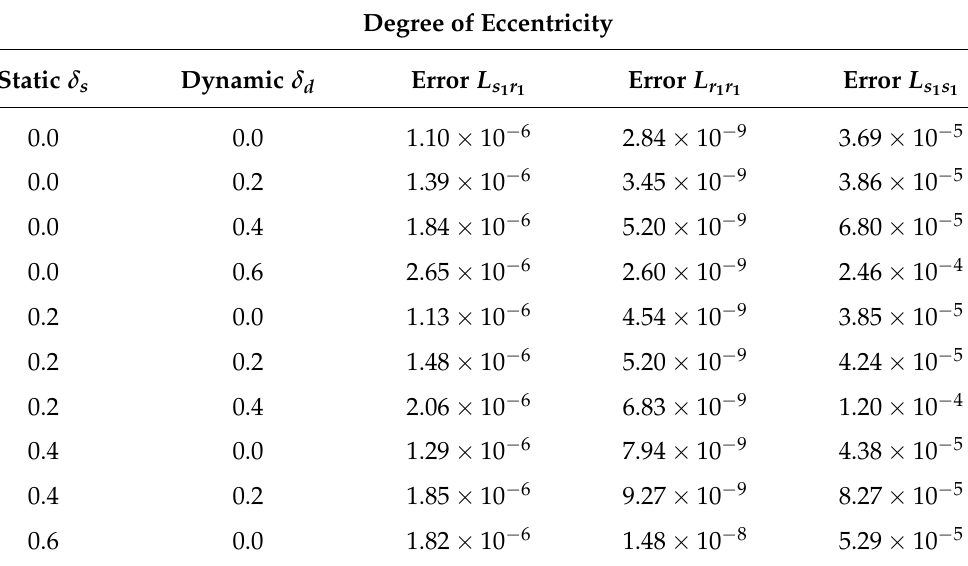
Table 1. RMSE of the proposed conformal winding tensor compared with